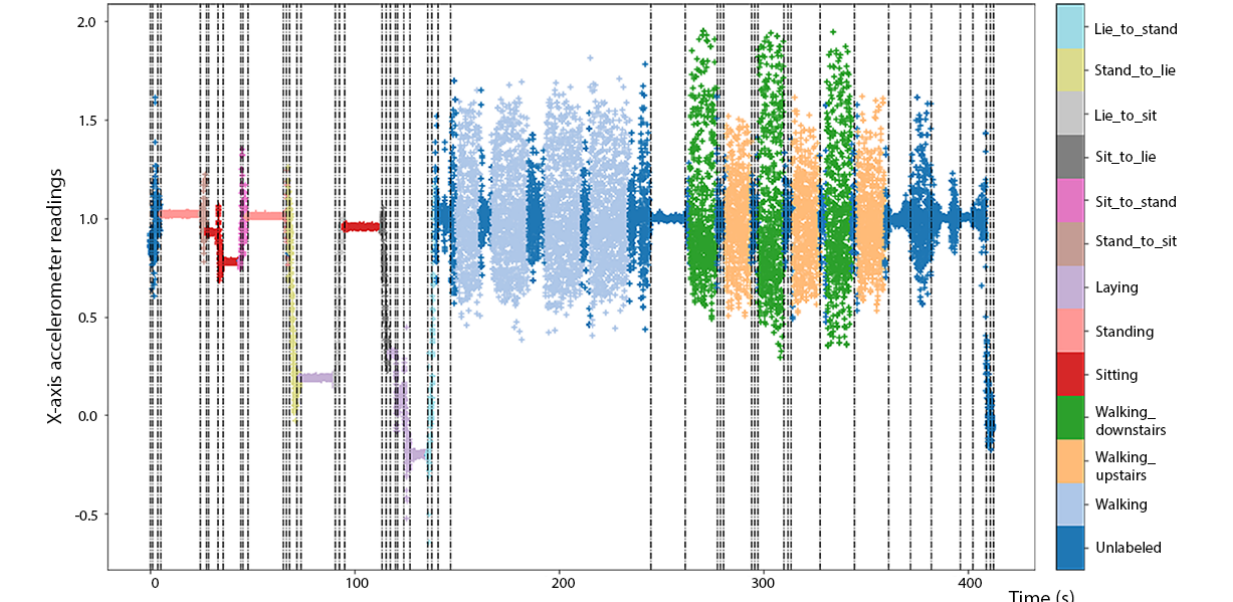
Figure 5. Multivariate segmentation break points (K=50) displayed using vertical dashed lines on the time series of x-axis accelerometer readings from experiment 1 in the human activity recognition using smartphones training